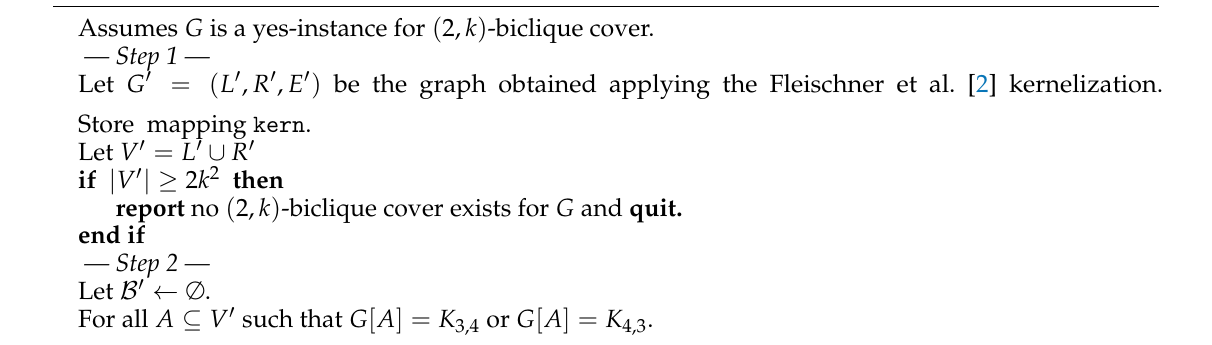
Algorithm 1 ApproxMaxCover( G = ( L , R , E ) , k